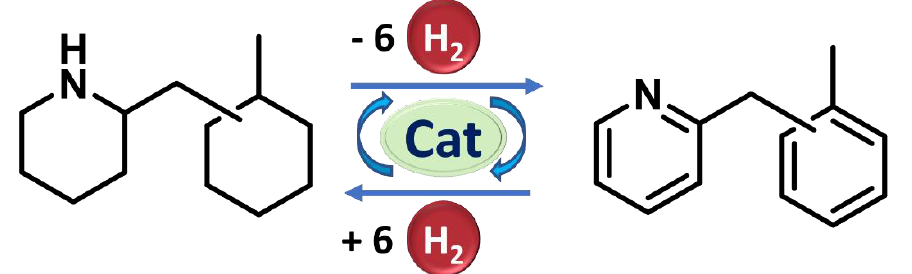
Figure 12. The schematic illustration of the perhydro-2-( n -methylbenzyl pyridine)/2-( n -methylbenzyl pyridine) LOHC system.